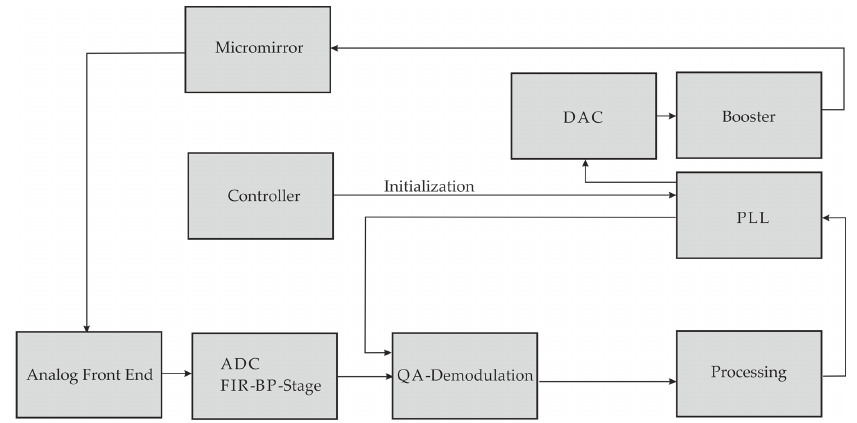
Figure 12. Block diagram of the closed-loop control for the piezoelectrically actuated and sensed micromirror. DAC = Digital-Analog-Converter; ADC = Analog-Digital-Converter; PLL = Phase-Locked-Loop; FIR = Finite-Impulse-Response, BP =